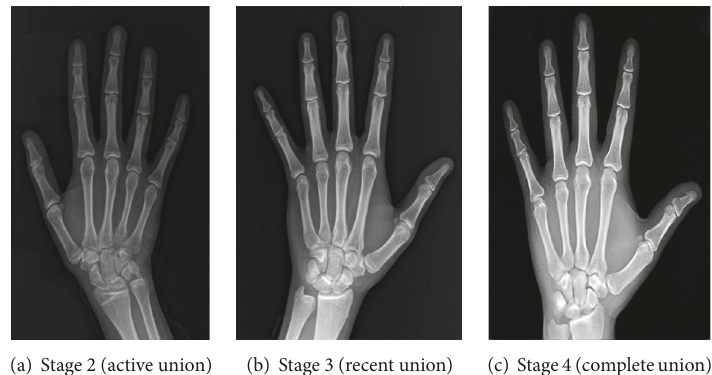
Figure 4: Radiographic images of hand joints showing stage 2 labeled as (a) and stage 3 labeled as (b) and stage 4 labeled as (c).